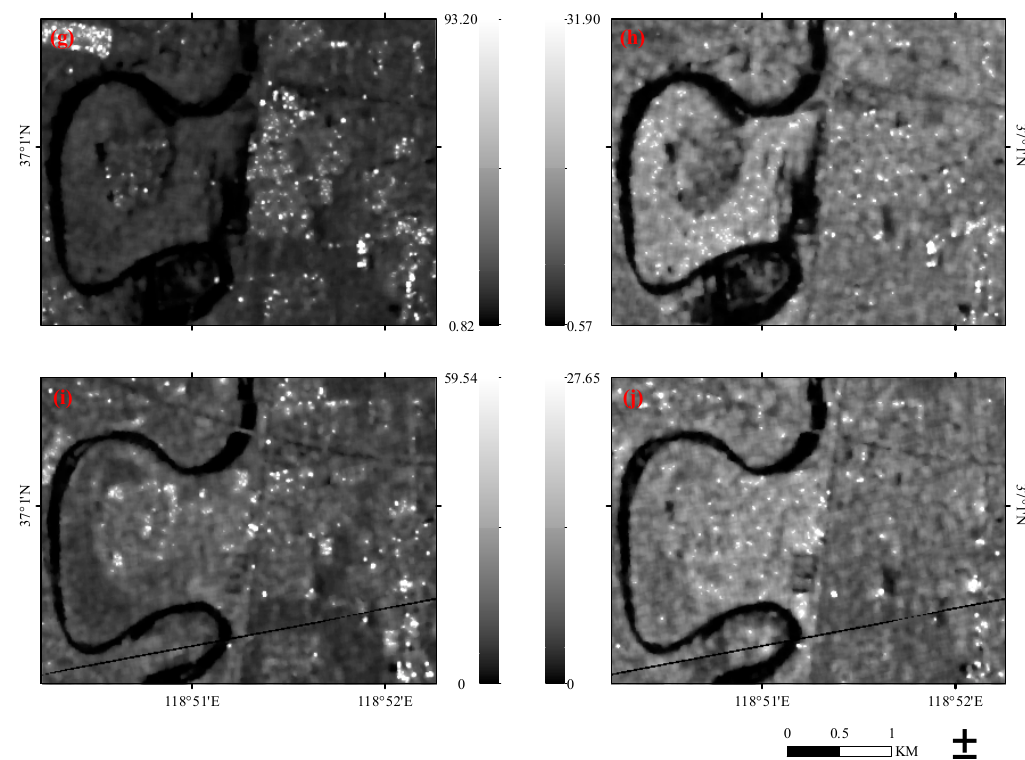
Figure 3. GRD products in Gamma bands and S_Gamma bands. ( a ) S_Gamma band of Vertical-Vertical polarization (VV) on 21 July 2018; ( b ) Gamma band of Vertical-Horizontal polarization (VH) on 21 July 2018; ( c ) S_Gamma band of VV on 27 July 2018; ( d ) S_Gamma band of VH on 21 July 2018; ( e ) S_Gamma band of VV on 2 August 2018; ( f ) S_Gamma band of VH on 2 August 2018; ( g ) S_Gamma band of VV on 20 August 2018; ( h ) S_Gamma band of VH on 20 August 2018; ( i ) S_Gamma band of VV on 26 August 2018; and ( j ) S_Gamma band of VH on 26 August 2018.